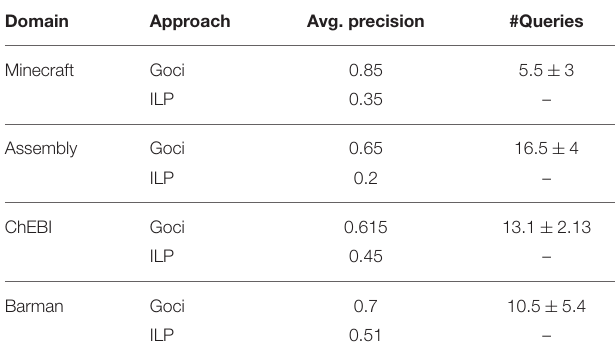
TABLE 1 | Results for one-shot concept learning.